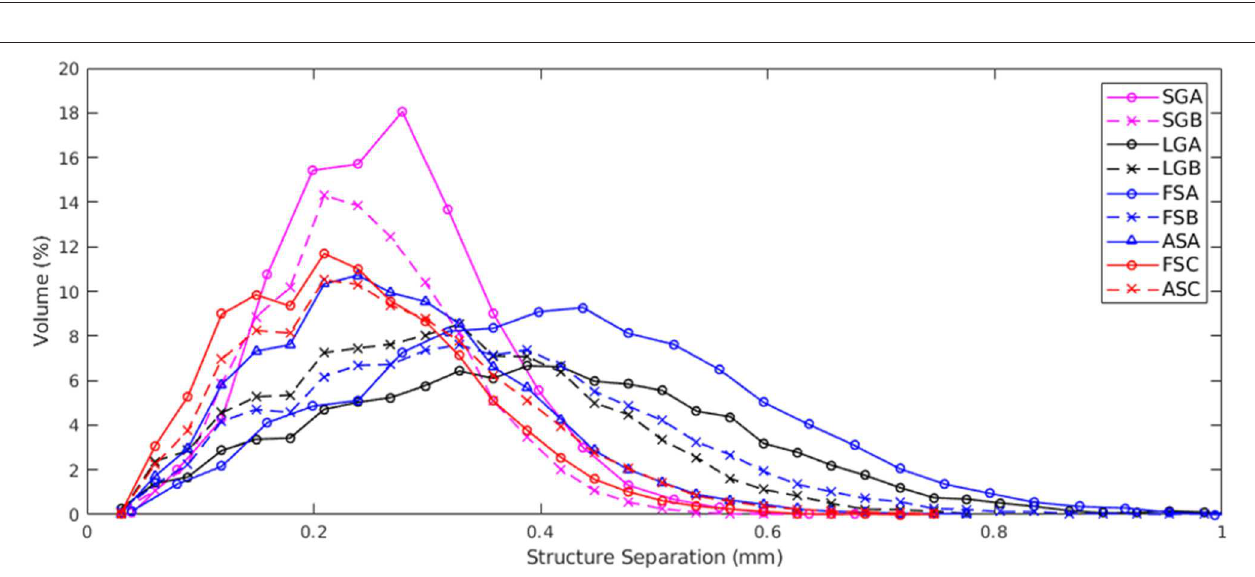
FIGURE 7 | Structure separation distributions for all samples. We note that samples generally fall into two classes: (1) fresh snow and large grain firn and (2) small grained snow and snow aged 1 day.